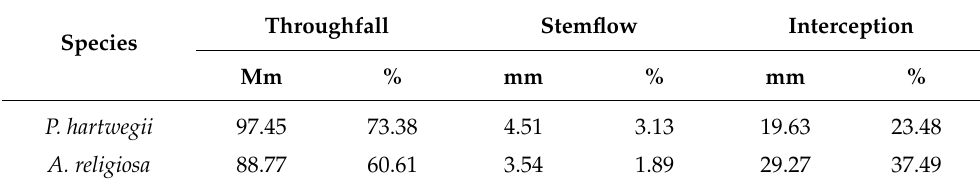
Table 7. Quantification of the interception components from the 20 rainfall events. Throughfall Stemflow Species